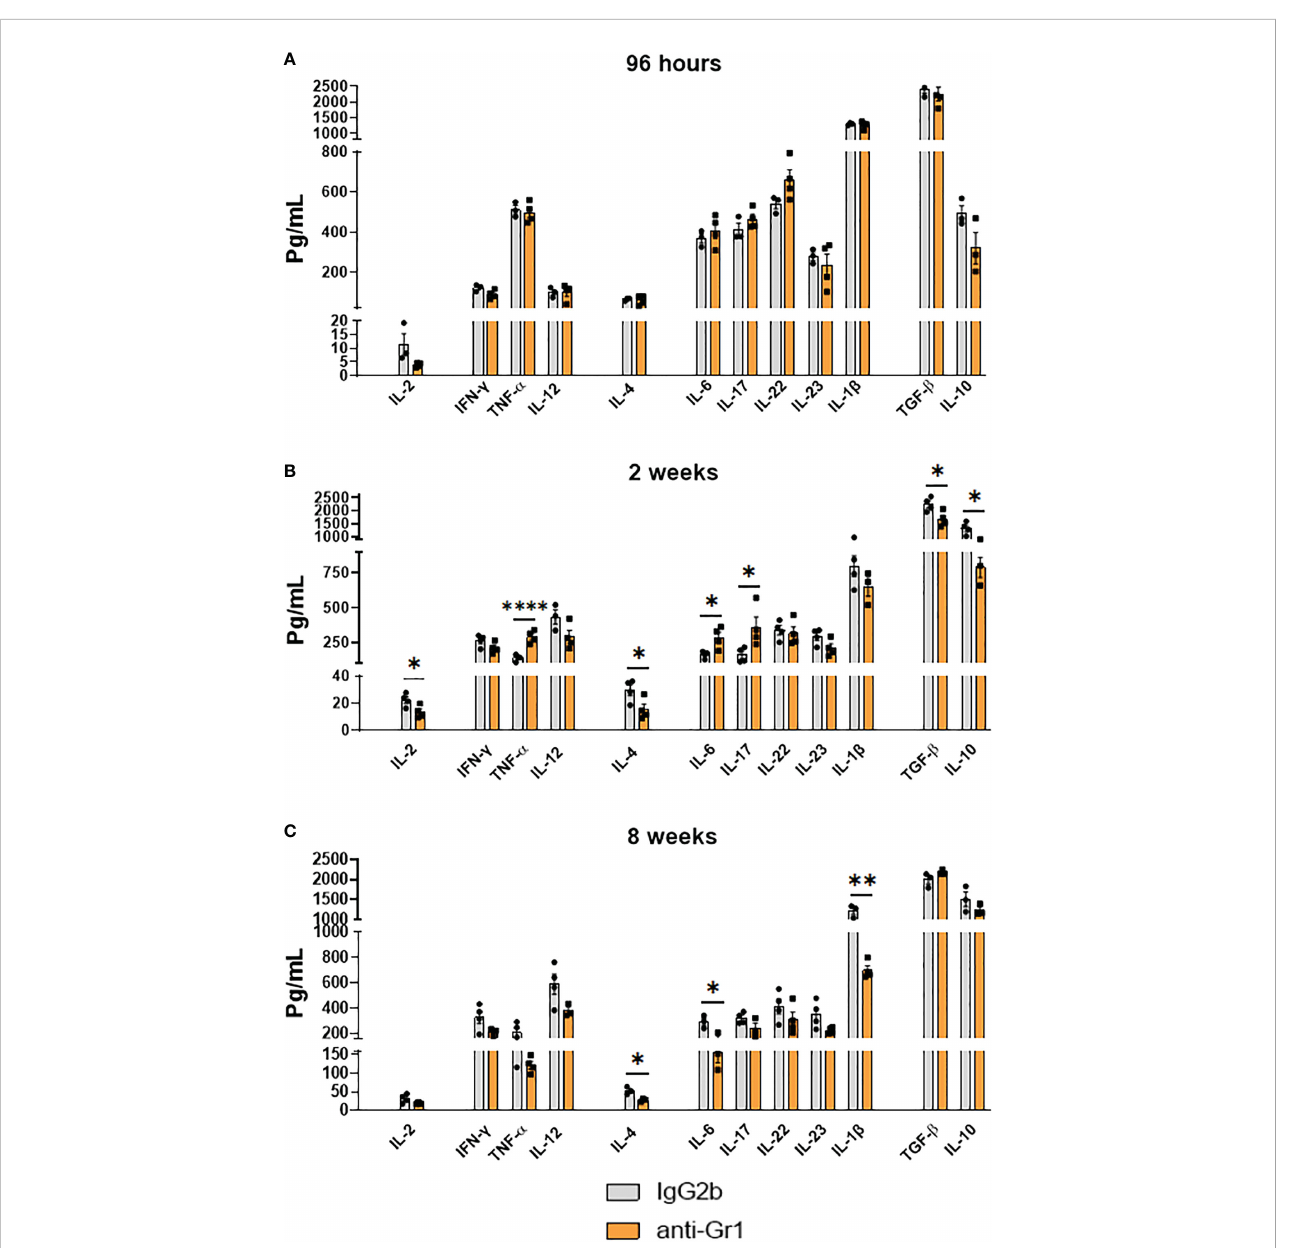
FIGURE 9 Effect of MDSC depletion in the levels of pulmonary cytokines of P. brasiliensis infected mice. Levels of cytokines in organ homogenates of anti-Gr1 and IgG2b control-treated mice were measured after i.t. infection with 1 × 10 6 yeast cells. Lungs were collected, disrupted in 5.0 ml of PBS, and the supernatants obtained were analyzed for cytokine content by capture ELISA. The levels of IL-2, IFN- g , TNF- a , IL-12, IL-4, IL-6, IL-17, IL-22, IL-23, TGF- b , IL-1 b , and IL-10 were analyzed at 96 hours (A) , 2 weeks (B) , and 8 weeks (C) of infection. Data represent 3 independent experiments with 3-4 mice each. For comparisons between two groups, the mean ± SEM was obtained and analyzed by the unpaired Student ’ s t -test. Differences were considered signi fi cant when: * p <0.05; ** p <0.01 and **** p